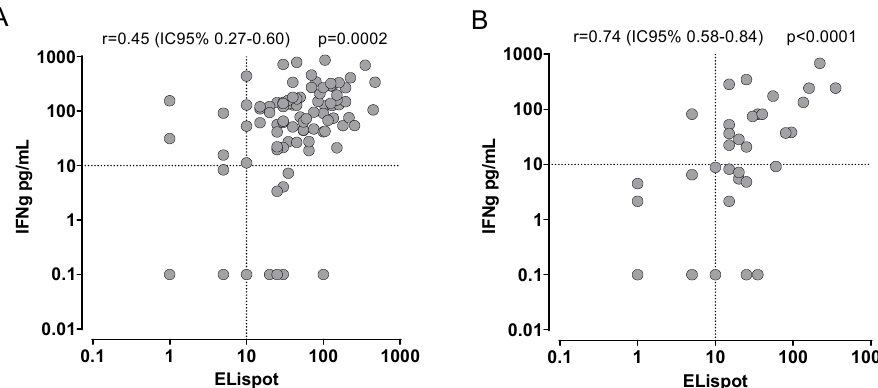
Figure 1. Correlation between HM-WB IGRA (IFN γ pg/mL) and ELISpot assay in HCWs ( A ) and ICs ( B ). Each dot represents a single sample; r and p value are given in the graph. HCWs: healthcare workers; ICs: immunocompromised subjects